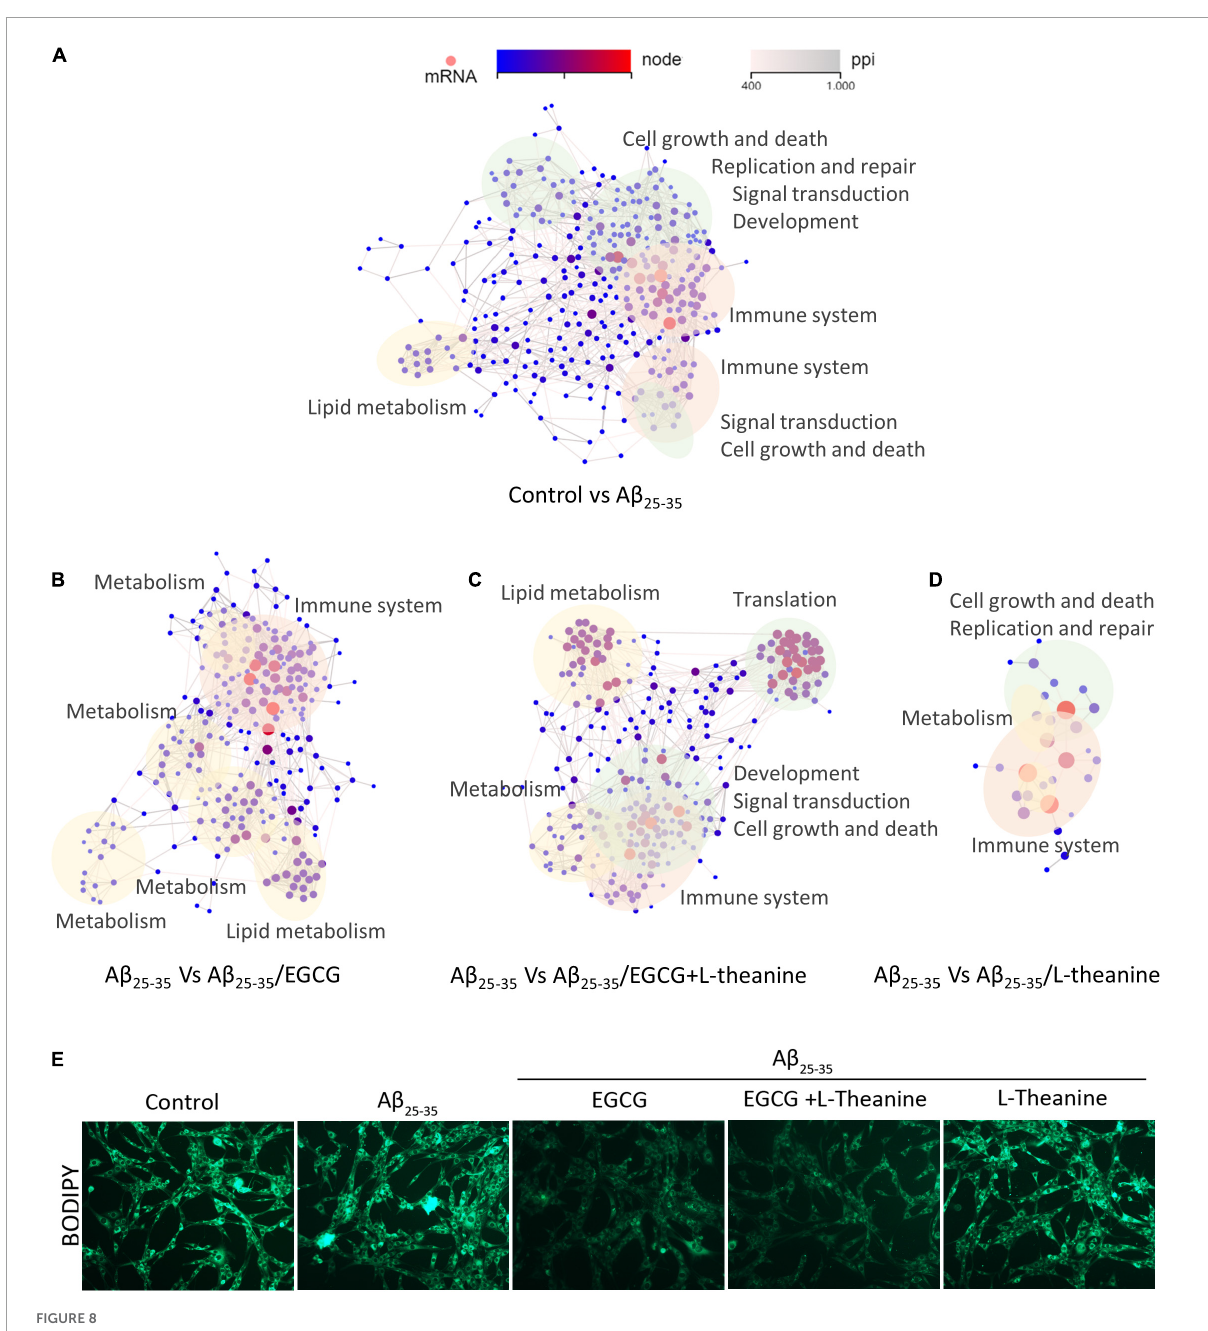
cell proliferation, inflammation, aging, and extracellular matrix ( Figure 7A ). DEGs in the A β 25 − 35 /EGCG group were mainly enriched in cell translation, extracellular matrix, wound healing, cytoplasm, and growth factor stimulation ( Figure 7B ). The